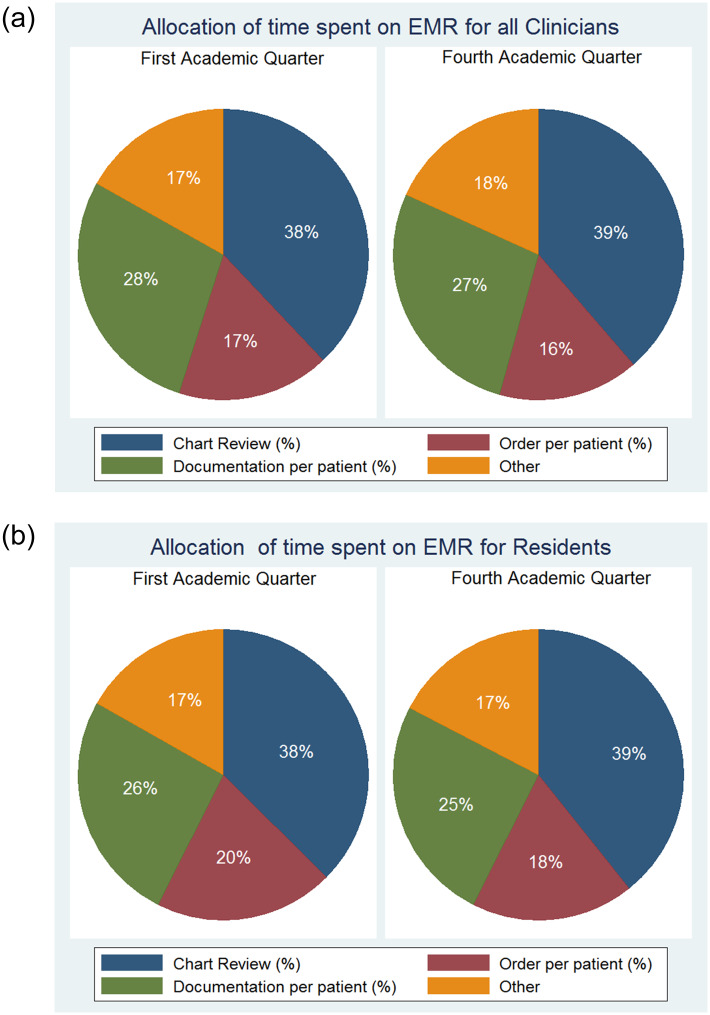
(a) Allocation of time on EMR for all Clinicians. (b) Allocation of time on EMR for all Residents.